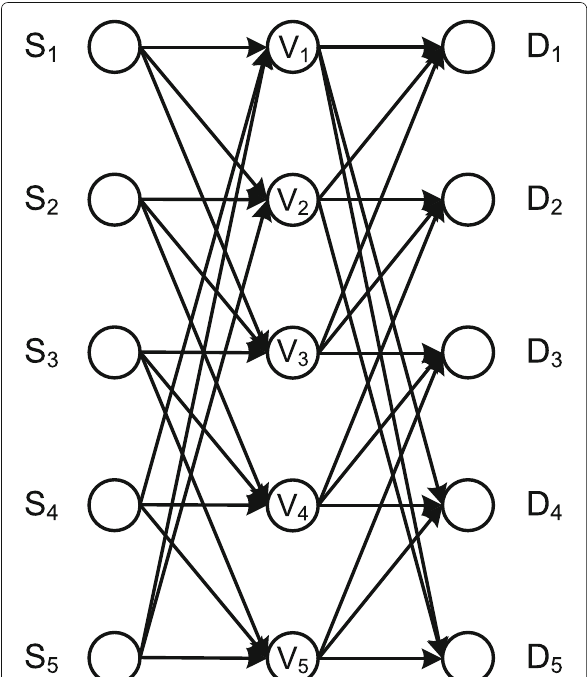
Fig. 13 A ( 5,3 ) two-layer folded-chain network